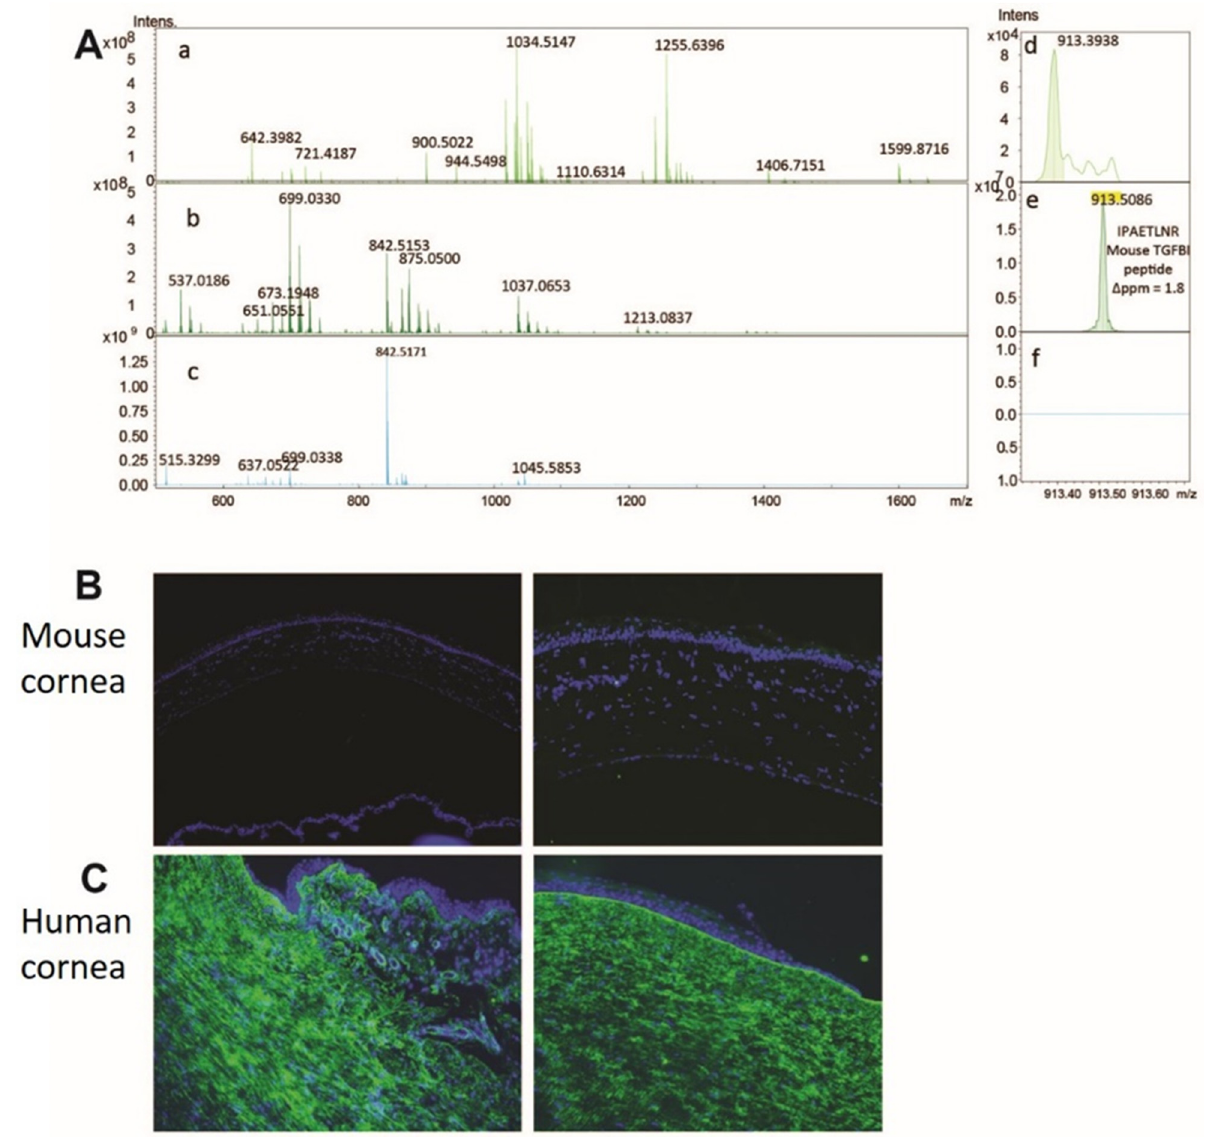
Figure 3. ( A ) ( a – c ): Peptide mass fingerprint spectra obtained in ( a ) Mouse cornea, ( b ) TGFBIp reference standard, ( c ) Control matrix with tryptic enzyme. ( d – f ): Corresponding zooms for one of the TGFBIp digests from the standard ( m / z 913.5086). ( B ) Immunohistochemistry results of TGFBIp staining on WT-mouse cornea indicating absence or extremely low expression of TGFBIp. ( C ) Immunohistochemistry results of TGFBIp staining on WT-human cornea indicating abundant presence throughout the cornea. The blue (DAPI) color stain indicates the presence of nucleus, and the green color indicates the presence of TGFBIp protein.